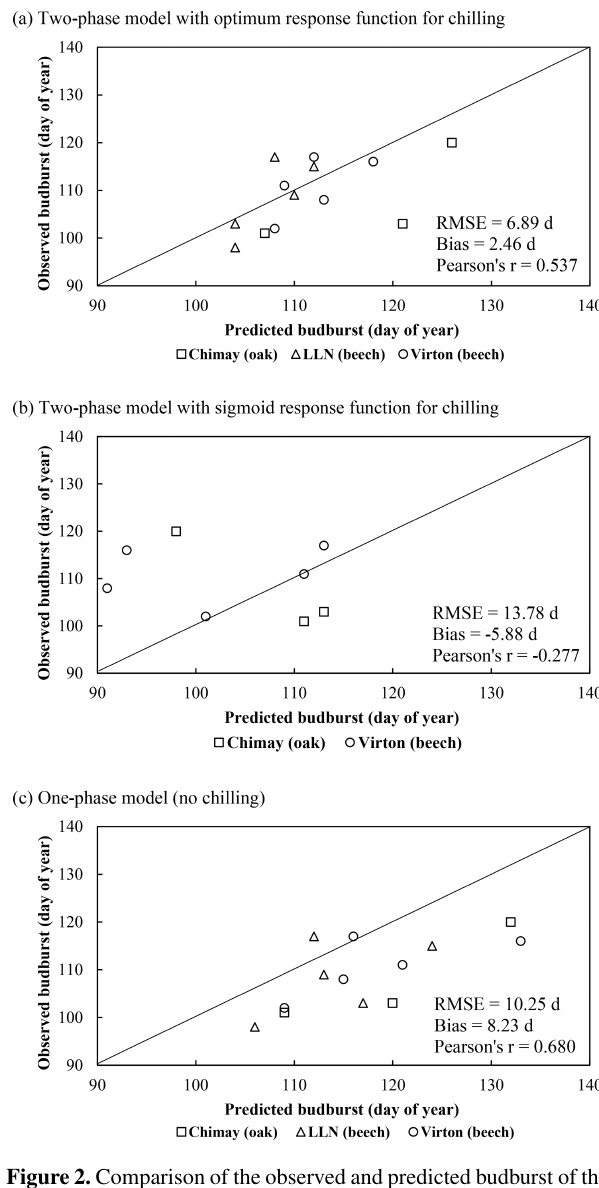
Figure 2. Comparison of the observed and predicted budburst of the median tree in Chimay, Virton and Louvain-la-Neuve for the three phenological variants implemented. The quality of the predictions is indicated by the RMSE, the absolute bias and the Pearson’s cor- relation coefficient ( r